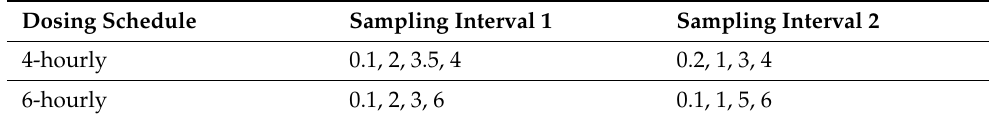
Table 3. Dosing and scheduling